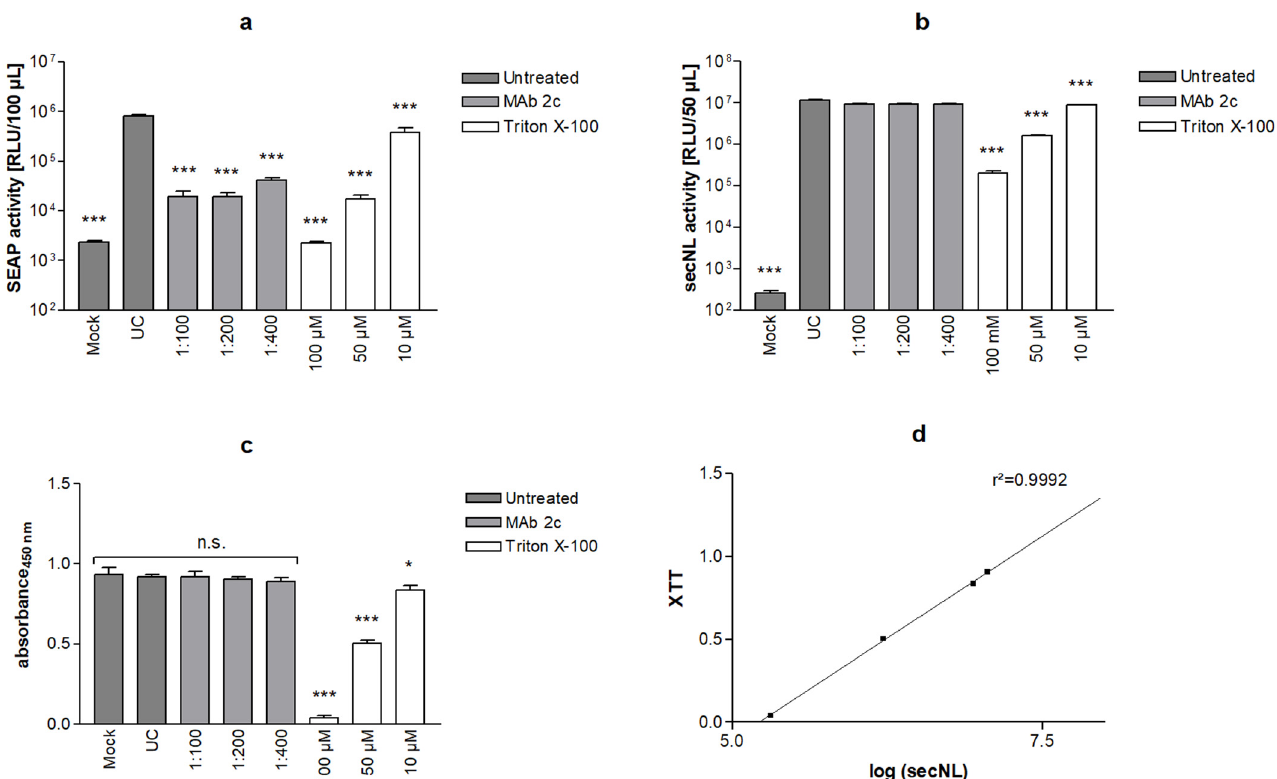
Figure 7. HSV-1 SRFIA on 96-well plates. Reporter cells cultivated on 6-well plates were co-transfected with vectors for gB-1 (500 ng), gD-1, gH-1, gL-1 (each 660 ng) and secNLuc (1 ng), transferred to 96-well plates and treated with the gB-1 specific monoclonal antibody MAb 2c or Triton X-100 as indicated. Untreated cells (UC, pos. fusion control) and cells transfected with empty gB-1 vector backbone (Mock, neg. fusion control) served as controls. 48 h after transfection, levels of SEAP ( a ) and secNLuc ( b ) were quantified in culture supernatants, and cell viability was determined by XTT assay ( c ). Significance is indicated compared to UC. Data represent means ± SD from quadruplicate. ( d ) correlation of secNLuc activity with XTT values, p < 0.05 (*), p < 0.001 (***).